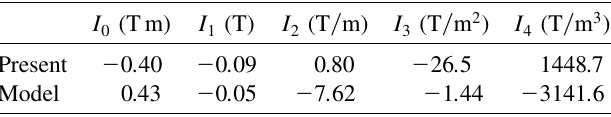
TABLE IV. Poles cut symmetrically to the average beam trajectory in the pole regions (short model): integrated coeffi- cients of the polynomial expansion of the magnetic field.